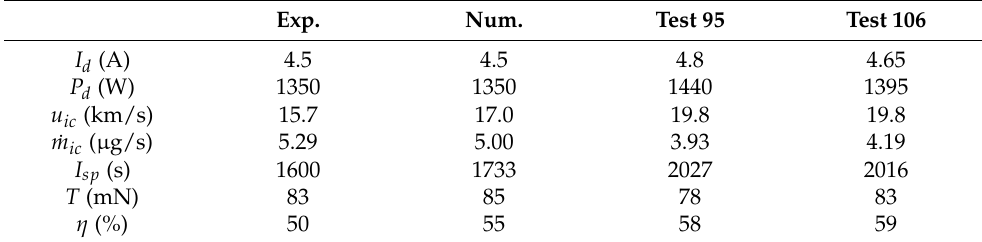
Table 4. SPT-100 performance: HYPICFLU tests vs. Exp. [37] and Num. [17] data.